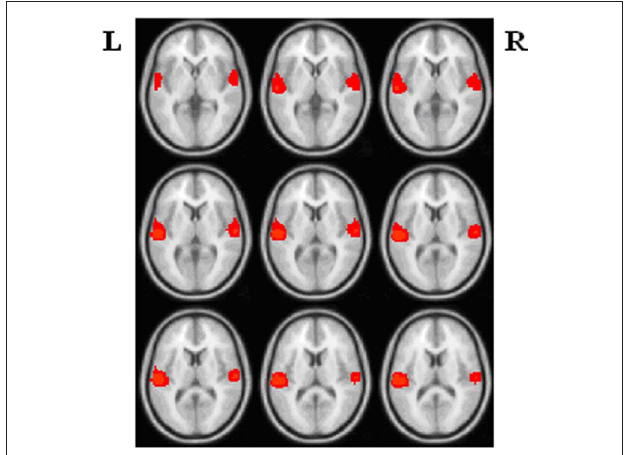
FIguRe 1 | Schematic location of the left and right task-related networks (L: left; R: